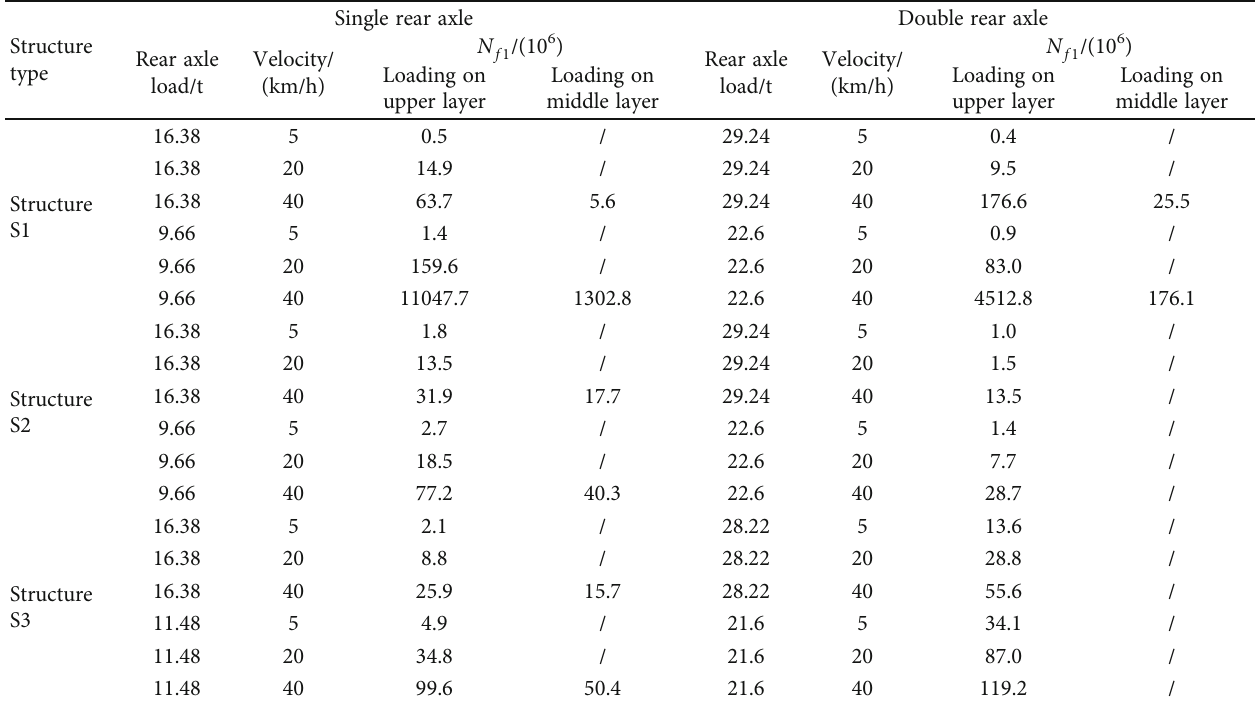
Table 1: Estimation fatigue life of asphalt